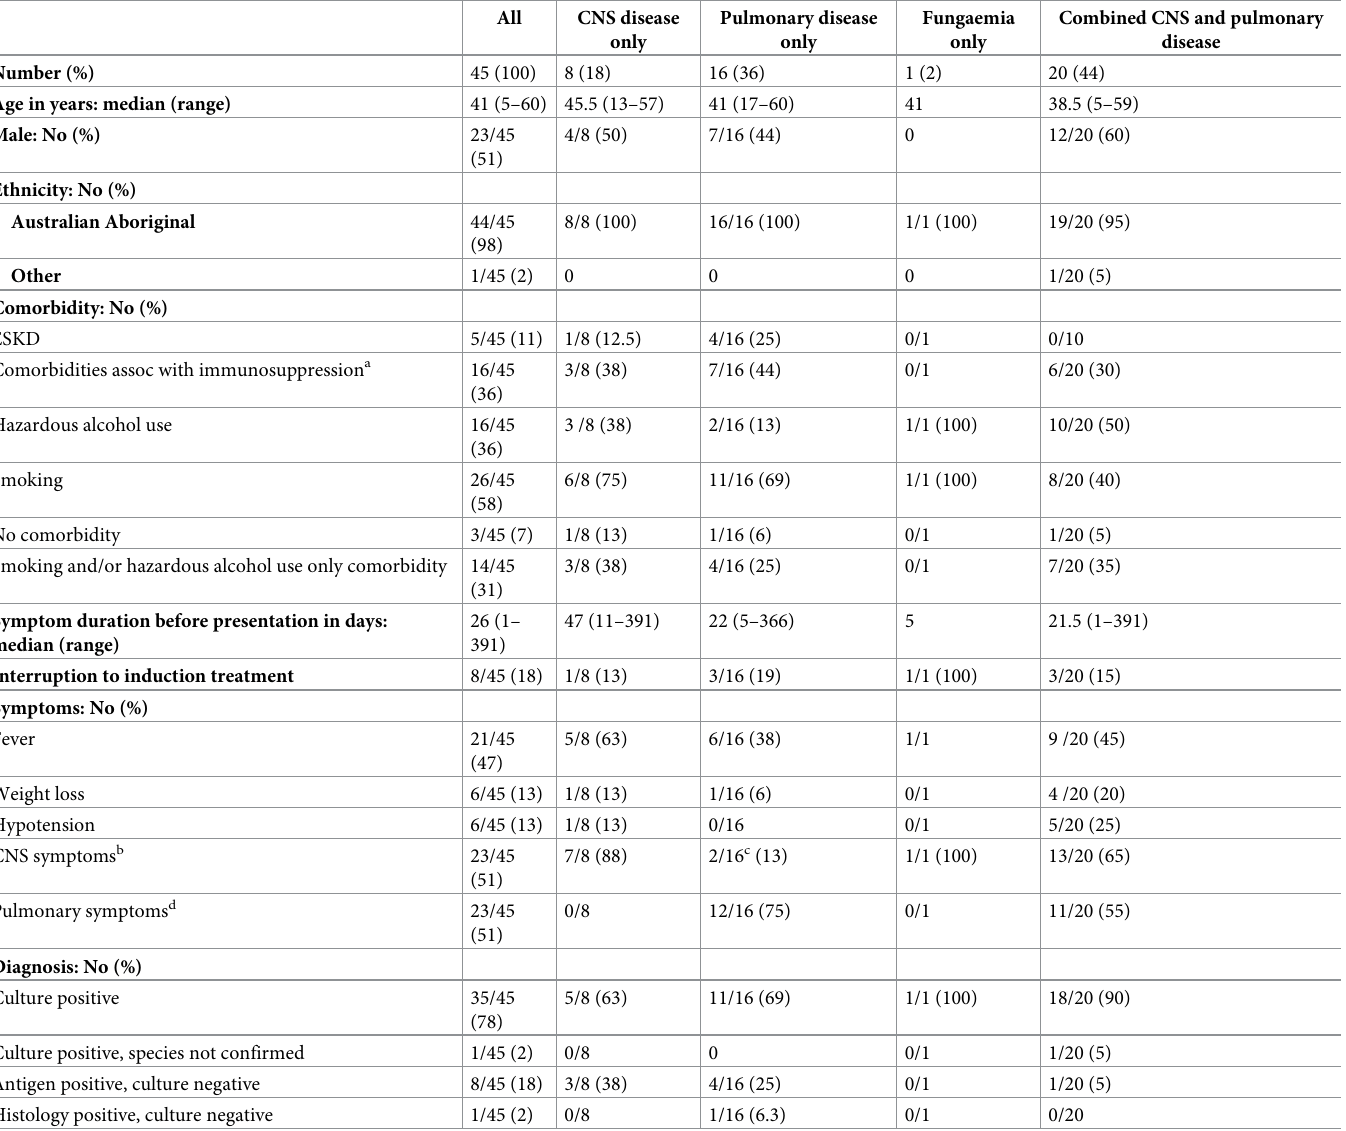
Table 1. Patient